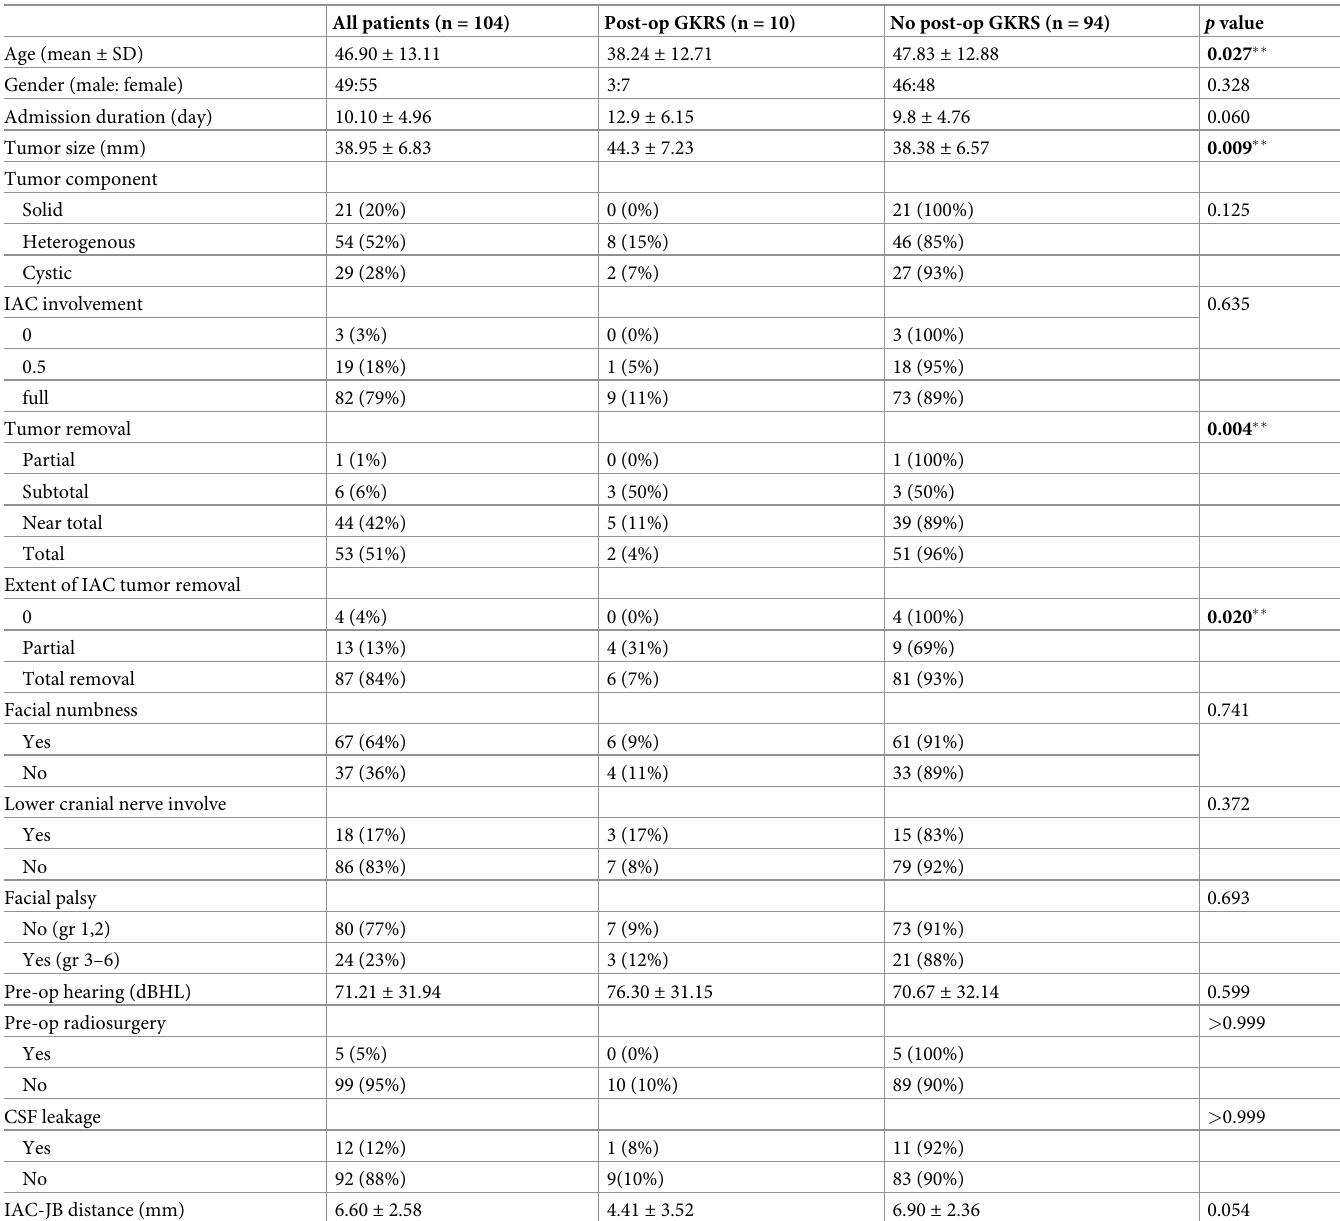
Table 3. Predictive factors for further tumor